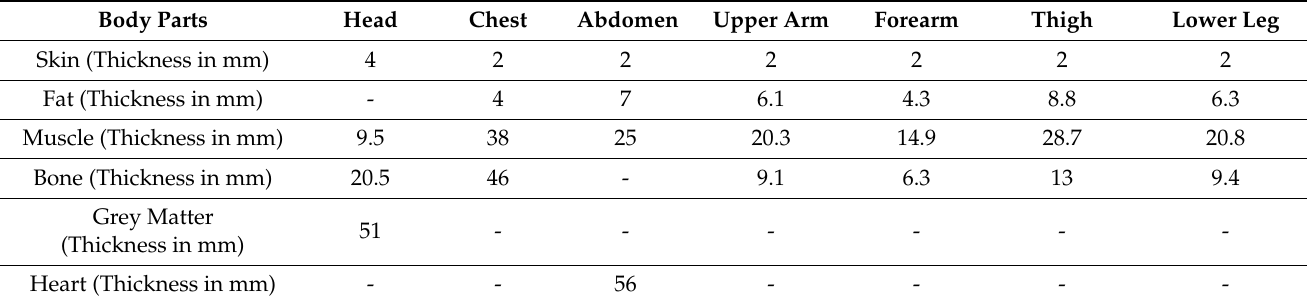
Table 5. Different tissue layers and their thickness in different parts of the body (Reprinted with permission from ref. [43]. 2018 Ashyap et al.).